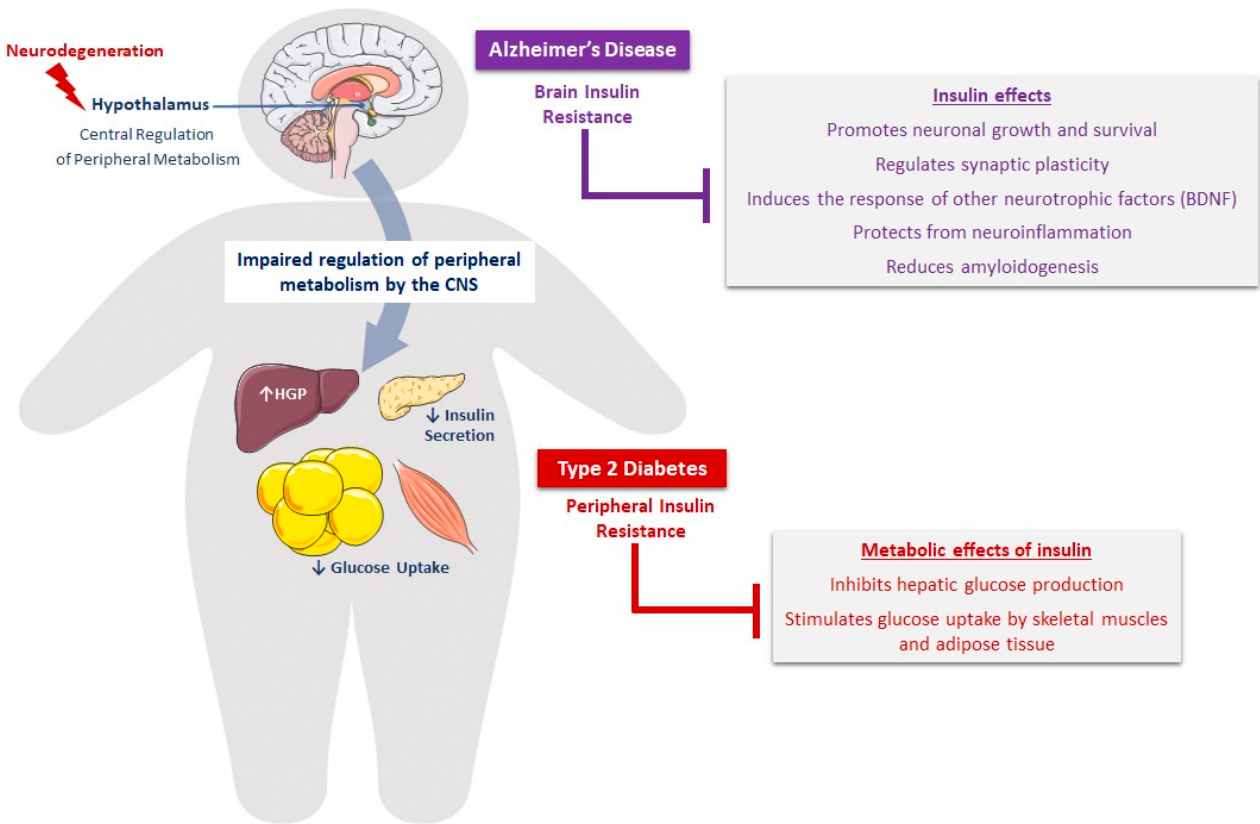
Figure 1. Defective insulin signaling as a major molecular mechanism linking T2D and AD. The pathophysiology of T2D implicates peripheral insulin resistance, leading to decreased glucose up- take by skeletal muscles and adipose tissue and increased hepatic glucose production (HGP). Be- cause insulin is a key neurotrophic and neuroprotective factor, brain insulin resistance would con- tribute to the pathogenesis of AD. Conversely, the neurodegeneration that occurs in the hypothala- mus leads to the impaired regulation of peripheral metabolism and defective insulin secretion by pancreatic β cells. β